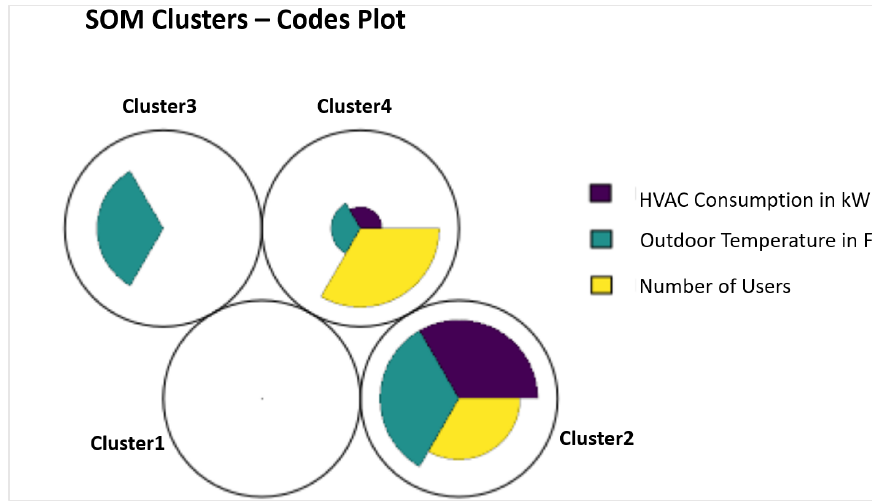
Figure 10. Data point grouping—fan diagram.